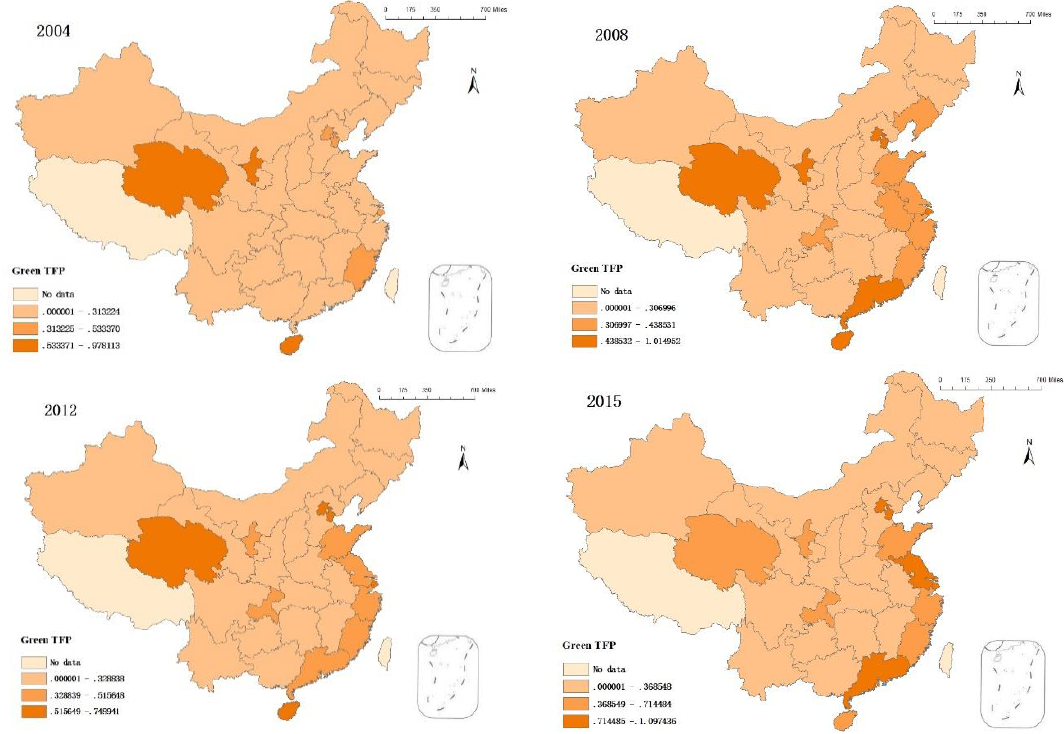
Figure 2. The temporal and spatial evolution of GTFP.